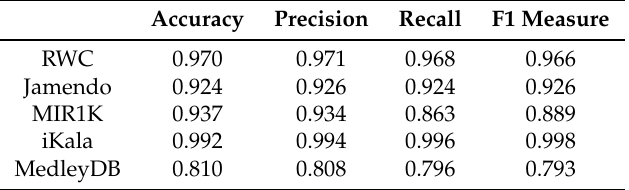
Table 2. The performance of the proposed singing voice detection system on five different datasets.